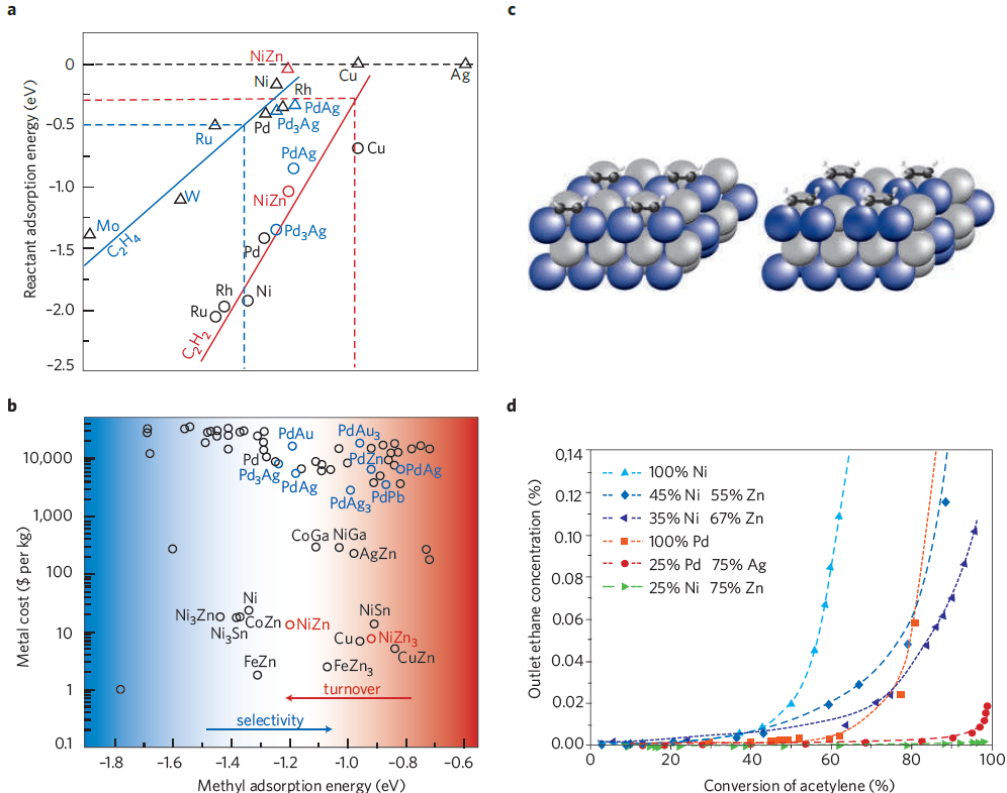
Figure 6. Catalysts design for selective acetylene hydrogenation. ( a ) Heats of adsorption for acetylene (C 2 H 2 ) and ethylene (C 2 H 4 ) plotted against the heat of adsorption for methyl (CH 3 ). The solid lines show the predicted acetylene (red line) and ethylene (blue line) adsorption energies from scaling. The dotted lines define the region of interest; ( b ) Price (in 2006) of 70 binary intermetallic compounds plotted against the calculated methyl binding energies. The smooth transition between regions of low and high selectivity (blue) and high and low reactivity (red) is indicated; ( c ) Modeling of the NiZn catalyst in the bcc-B2 (110) structure. The Ni atoms are shown as blue and Zn as gray. The adsorption of acetylene (left) and ethylene (right) is shown (small black and white structures); ( d ) Measured concentration of ethane at the reactor outlet as a function of acetylene conversion for seven catalysts. Ethane production is a measure of the selectivity of acetylene hydrogenation, and zero ethane corresponds to the most-selective catalyst. Experimental details are given in the corresponding reference. Adapted with permission from [86], Springer Nature, 2009.